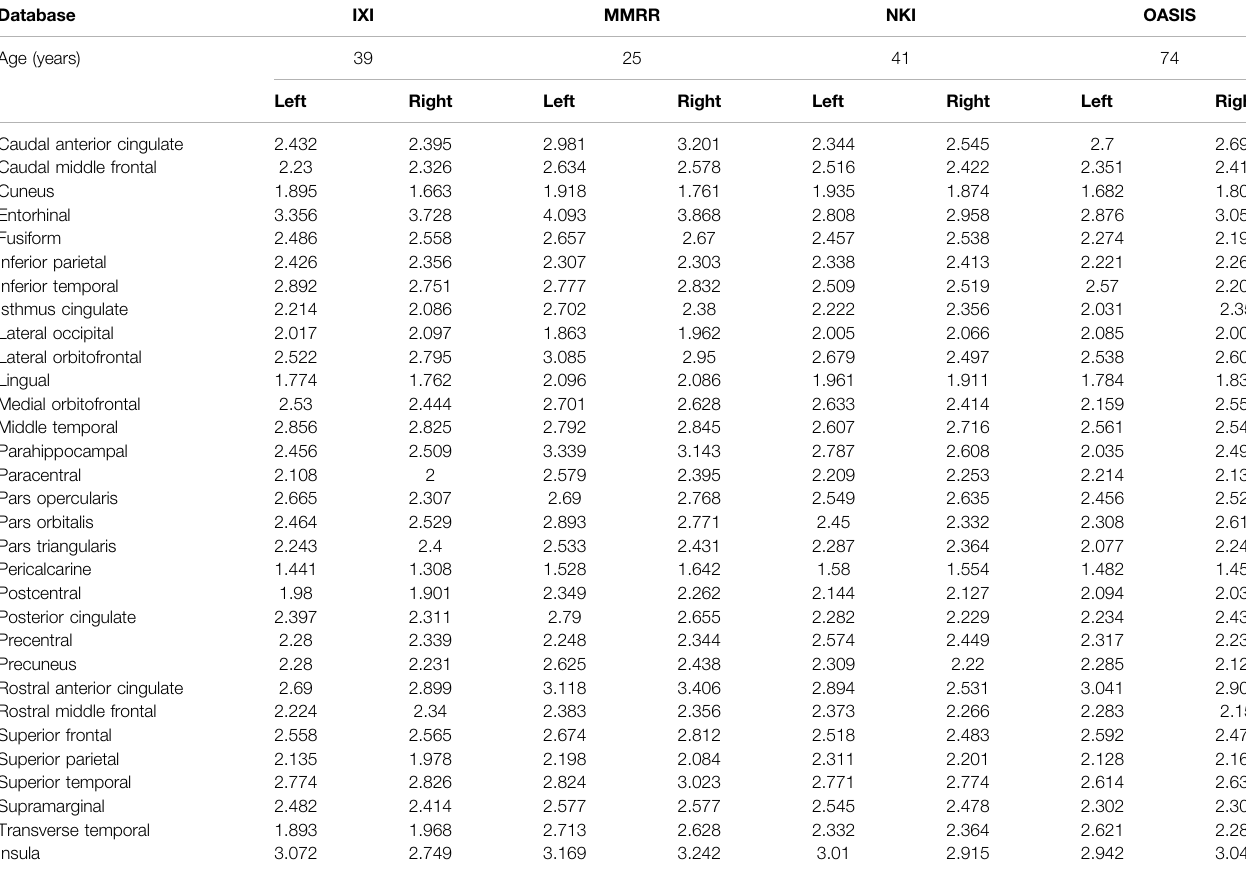
TABLE 1 | Cortical thickness in millimeters from one person in each